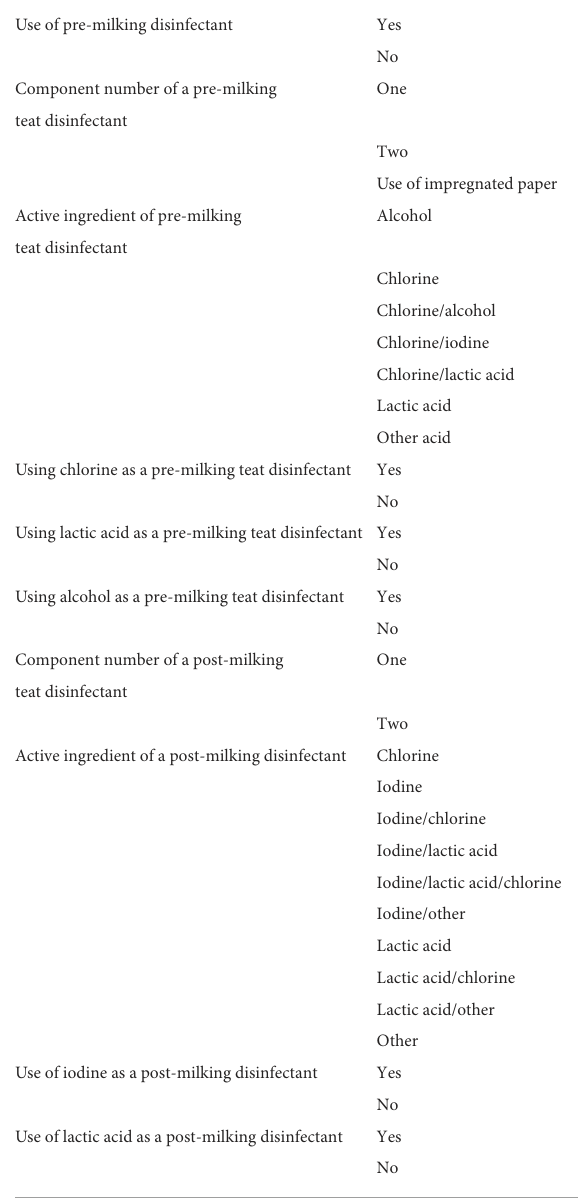
TABLE 1 The analyzed teat disinfection explanatory